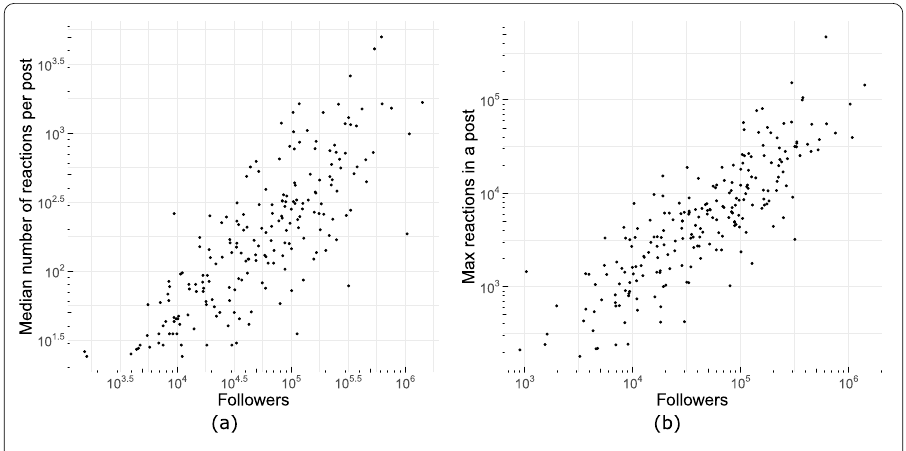
Figure 14 Number of followers and reactions by each party. ( a ) Median reactions per post ( b ) Maximum amount of reactions in a